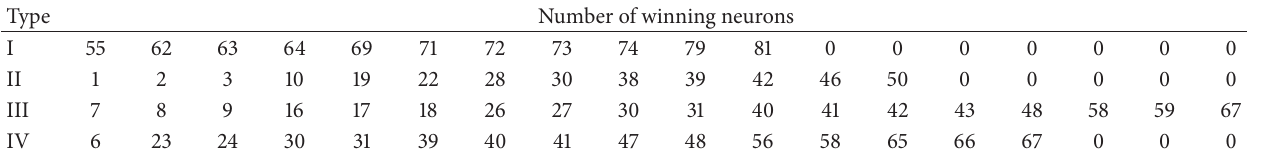
Table 3: Number of winning neurons corresponding to fault class of SOM neural network.